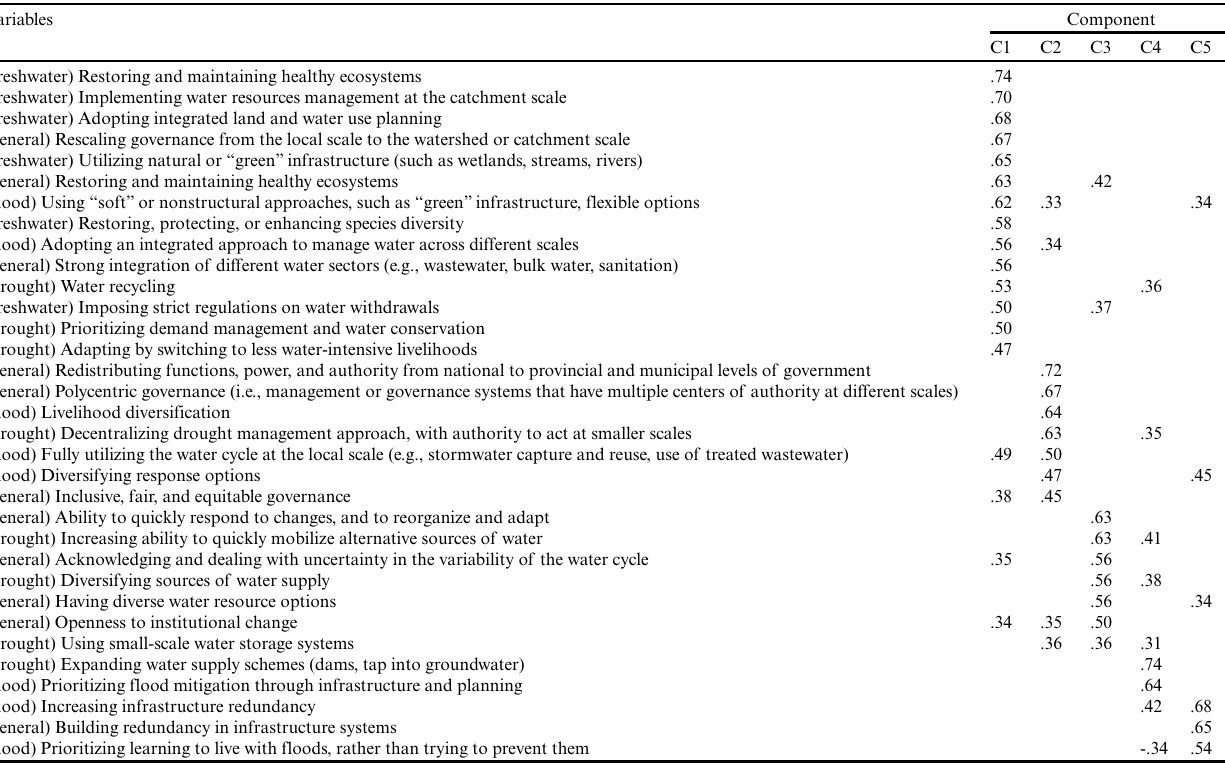
Table 1. PCA rotated component matrix. This table shows which variables were included in each component (C1–5). On the left-hand side are the strategies. In brackets are the categories they were included under: general strategies for building resilience in the water sector, strategies for drought resilience, flood resilience, and resilience in freshwater systems (i.e., eco-hydrological systems). Only loadings above 0.30 are shown. The 0.30 cut-off threshold was used as recommended by Laerd Statistics (2015). Note: the negative loading in C4 (see bottom of table) implies a negative relationship between the variable and the component, indicating that respondents who highly rated the other variables in this component were not likely to rate “Prioritizing learning with floods” high. All the other loadings are positively